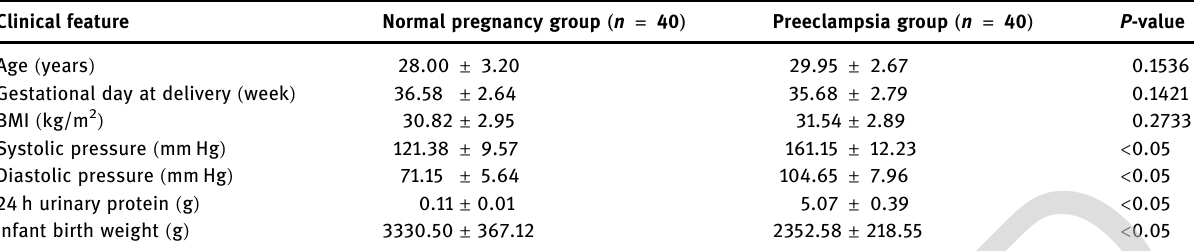
Table 1: Clinical data of subjects Clinical feature Normal pregnancy group ( n = 40 )